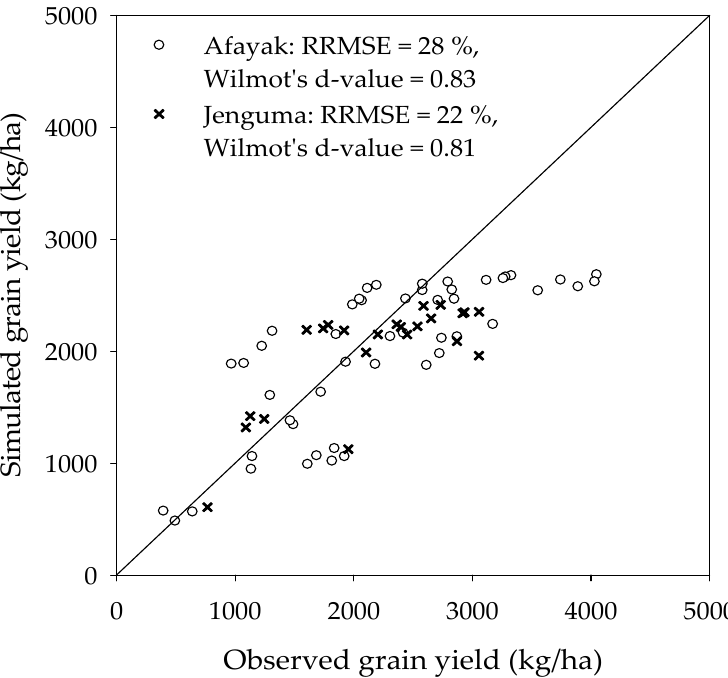
Figure 5. Performance of the DSSAT model in simulating soybean grain yield for evaluation.